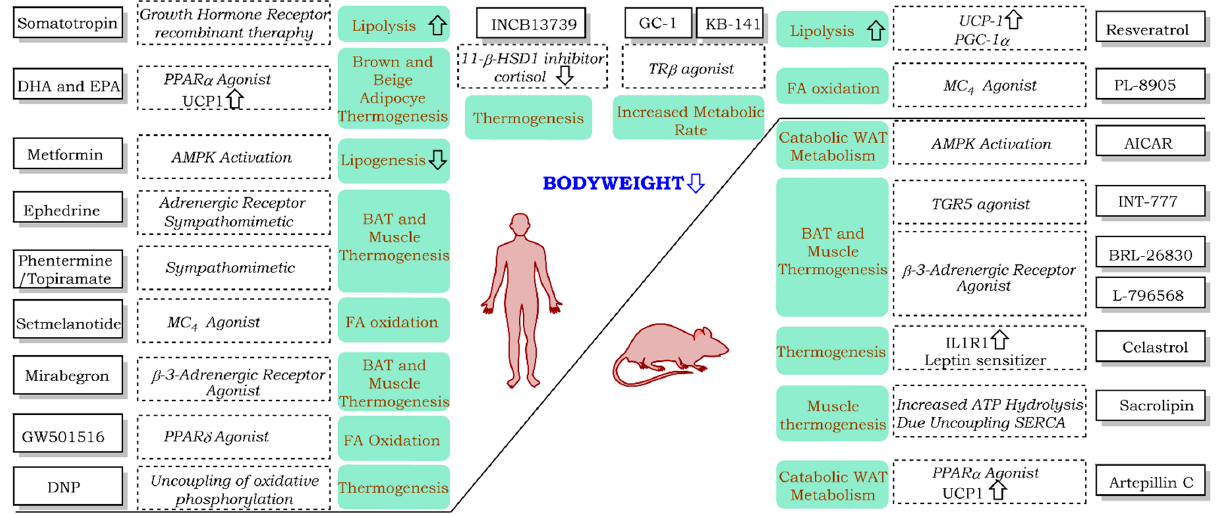
Figure 2. Drugs, their targets, and their metabolic outcomes focusing on energy expenditure effect.